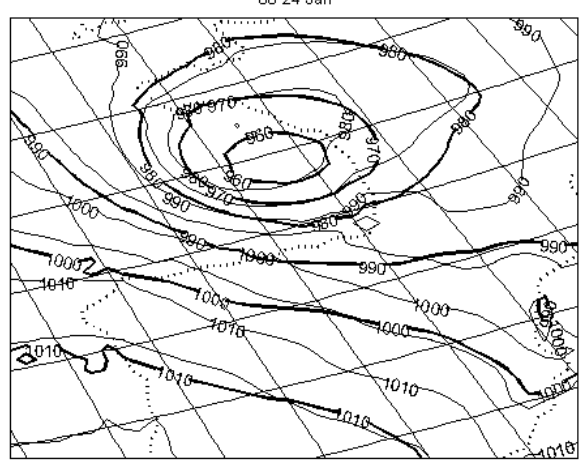
Figure 4. MSLP [hPa] for control experiment SST0 (thin line) and experiment SST9 (thick line) at 00 UTC 24, when the cyclone is over the Bay of